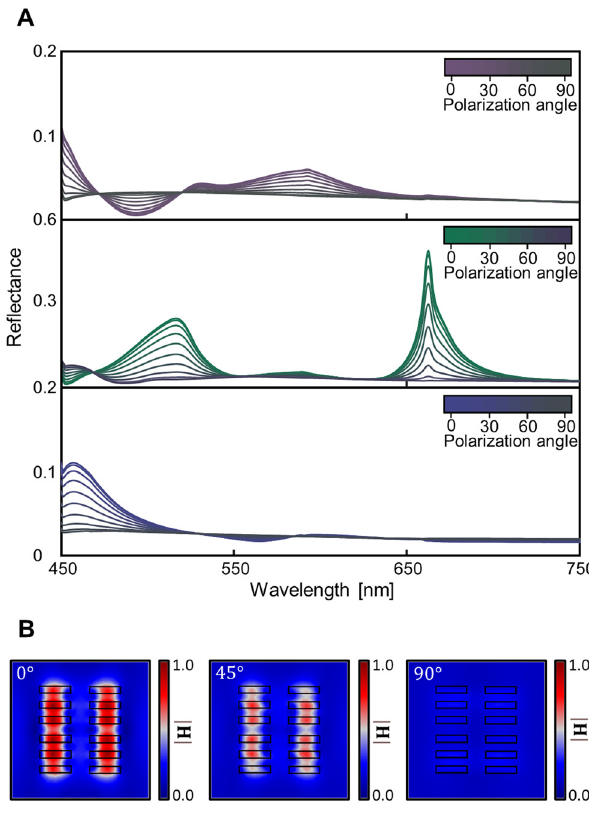
Figure 3: (A) Polarization angle dependency of red, green, and blue metasurfaces where the polarization angle increases from 0 ° to 90 ° in steps of 10 ° . The intensity of re fl ectance spectra decreases gradually as the polarization is rotated from 0 ° to 90 ° . The re fl ectance spectra of the three colors are expressed in the different scales in order to clarify the spectral peaks. Since the green structureshavealargervolumeofhydrogenatedamorphoussilicon, it has the strongest resonant peak compared to red and blue ones. (B) The magnetic fi eld distribution at λ = 670 nm varies for different polarization angles. l 1 = l 2 = l 3 = 270 nm and the height of cross- sectionof fi elddistributionis h /2.Theintensityofthemagnetic fi eld is normalized with respect to the maximum of 0 °